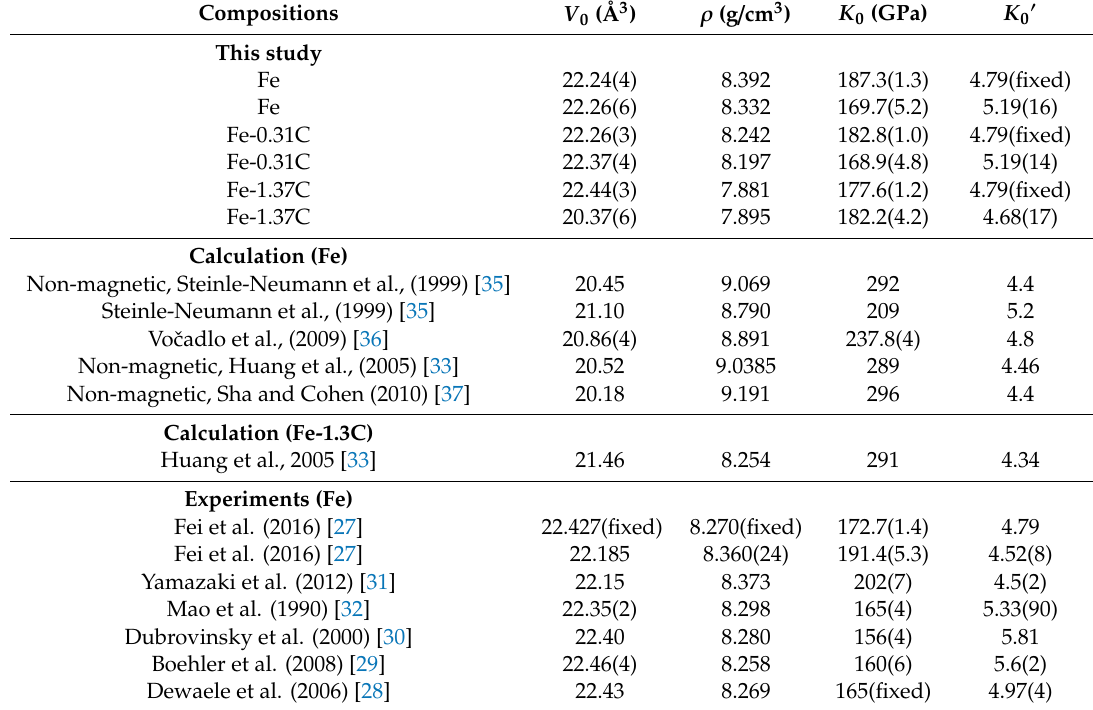
Table 1. Elastic parameters for hcp-structure of Fe and Fe-C alloys in this and previous studies.